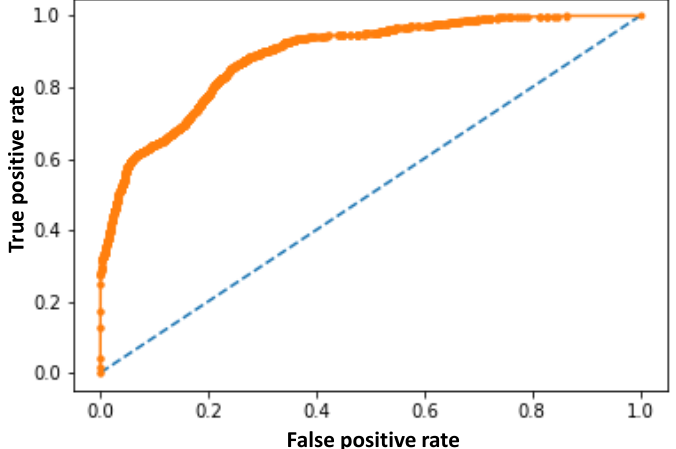
Appl. Sci. 2019 , 9 , x 12 of 23